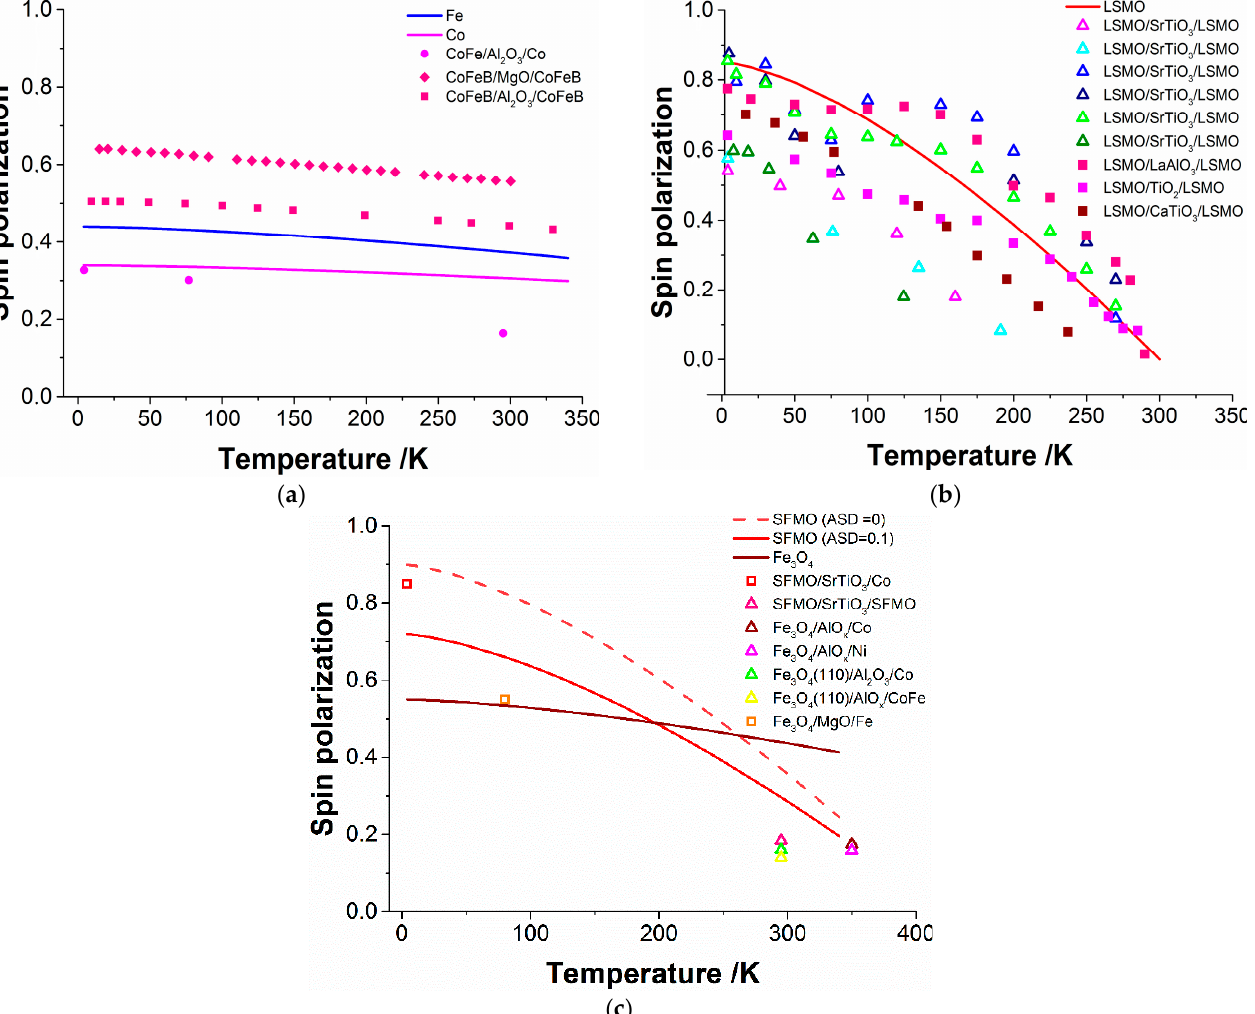
Figure 1. Temperature dependence of the tunneling spin polarization for FM metal, in comparison with experimental data of CoFe/Al 2 O 3 /Co [8], CoFeB/Al 2 O 3 /CoFeB, and CoFeB/MgO/CoFeB [33] ( a ); for LSMO, in comparison with the experimental data of LSMO /SrTiO 3 /LSMO [43-45], LSMO/SrTiO 3 /LSMO, LSMO/TiO 2 /LSMO, LSMO/LaAlO 3 /LSMO [31], LSMO/SrTiO 3 /LSMO, and LSMO/CaTiO 3 /LSMO [46] ( b ); for SFMO, in comparison with the experimental data of SFMO/SrTiO 3 /Co [41] and SFMO/SrTiO 3 / SFMO [47], as well as Fe 3 O 4 in comparison with experimental data of Fe 3 O 4 /AlO x /Co, Fe 3 O 4 /AlO x /Ni [16], Fe 3 O 4 (110)/AlO x /CoFe [48], Fe 3 O 4 (110)/Al 2 O 3 /Co [49], and Fe 3 O 4 /MgO/Fe [50] ( c ).